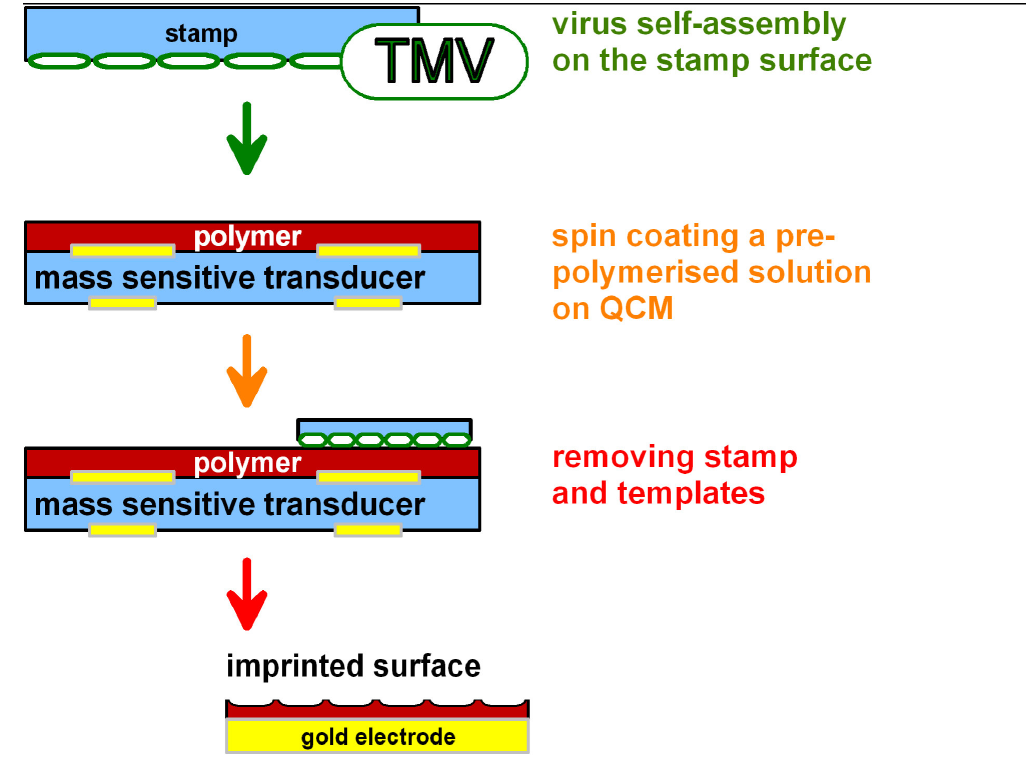
Figure 8: Stamping technique for viruses